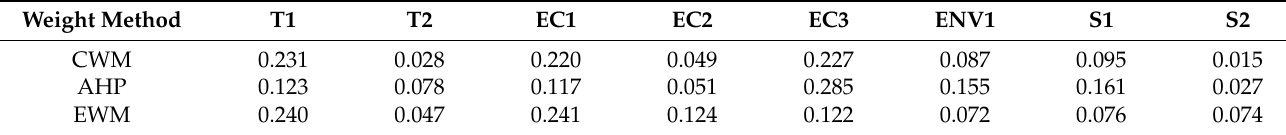
Table 7. Criteria weights from the different methods.